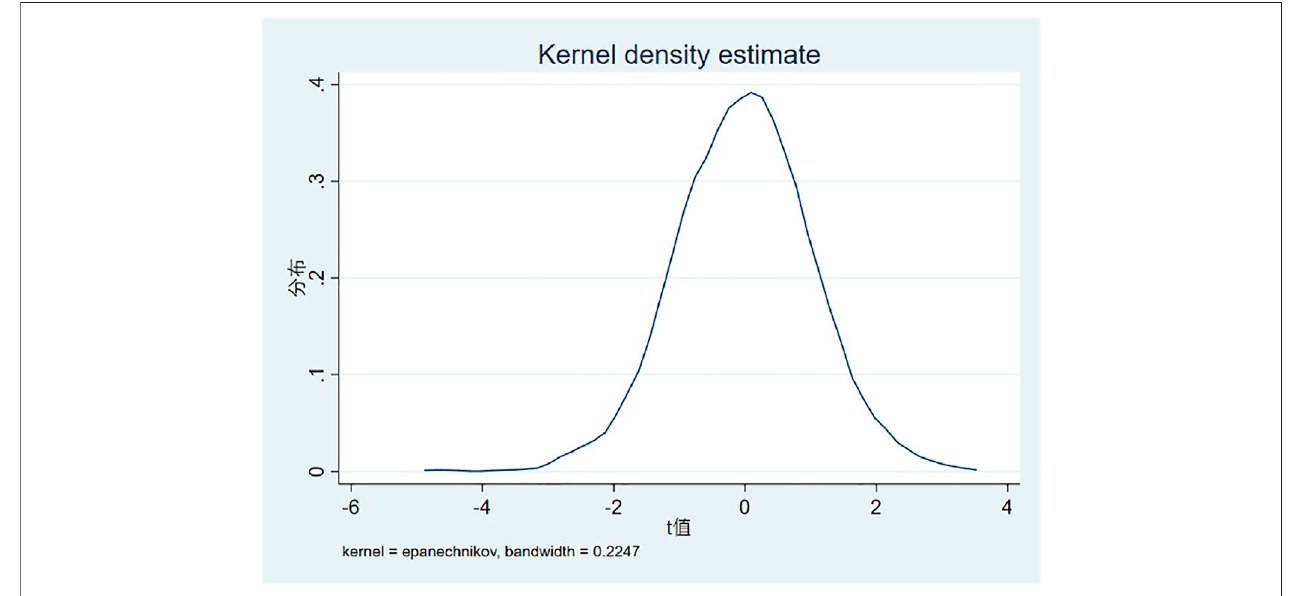
FIGURE 3 | Pindex kernel density